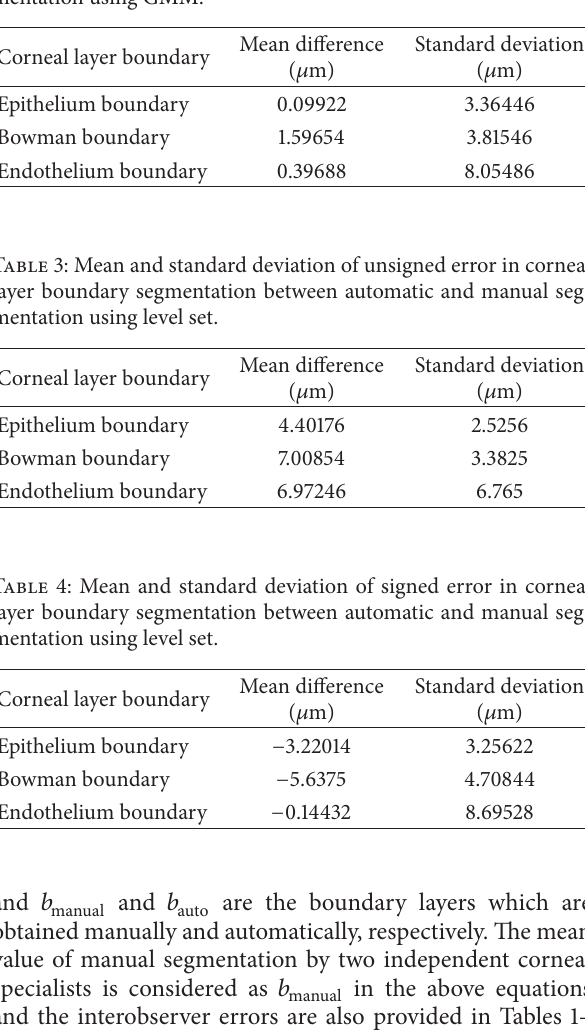
Table 2: Mean and standard deviation of signed error in corneal layer boundary segmentation between automatic and manual seg- mentation using GMM.